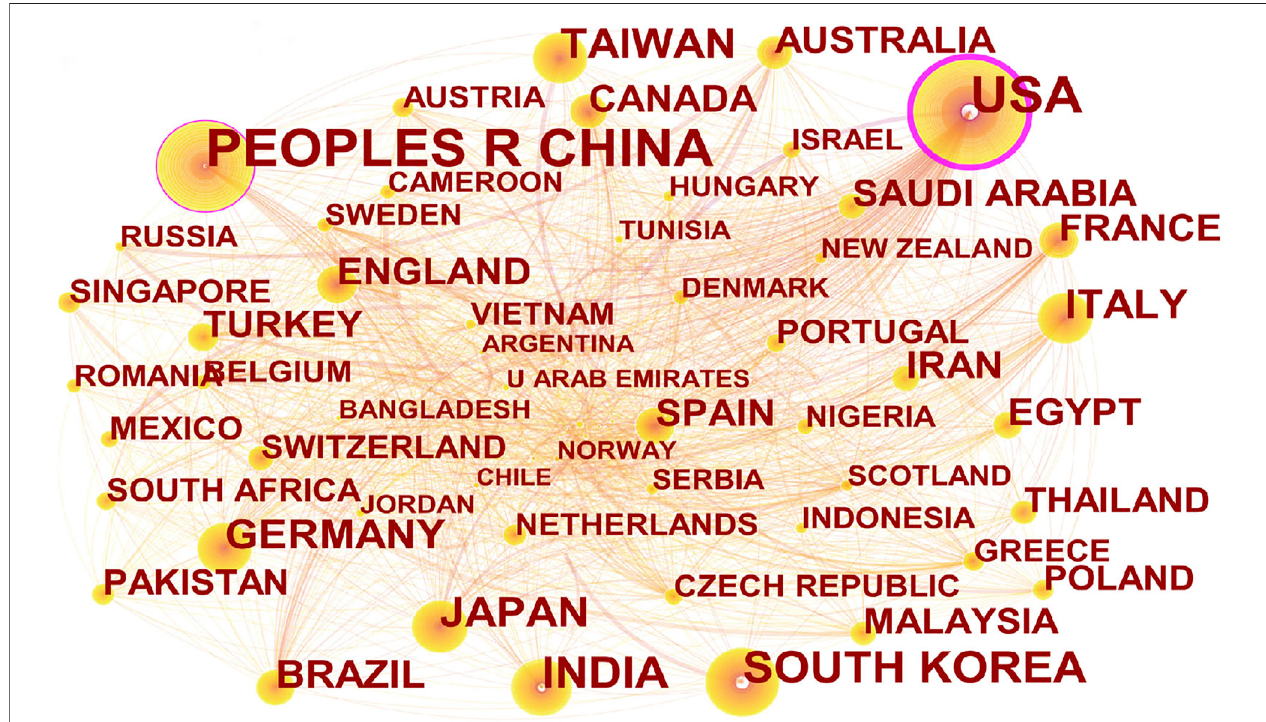
FIGURE 8 | National or regional cooperation network. China ranks fi rst in the number of articles published; the United States and China have higher centrality. The sizeofthenodesrepresentsthenumberofarticlespublishedbythecountry,thelinesbetweenthenodesrepresentthecooperativerelationship,andthethicknessofthe lines represents the co-occurrence strength. Nodes with centrality greater than 0.1 are marked with a purple outer circle.